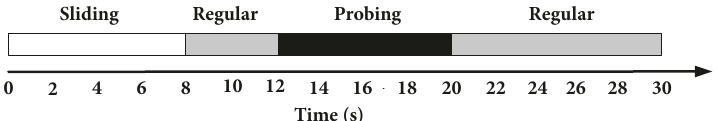
Figure 16: The gait classification result of the neuron network.